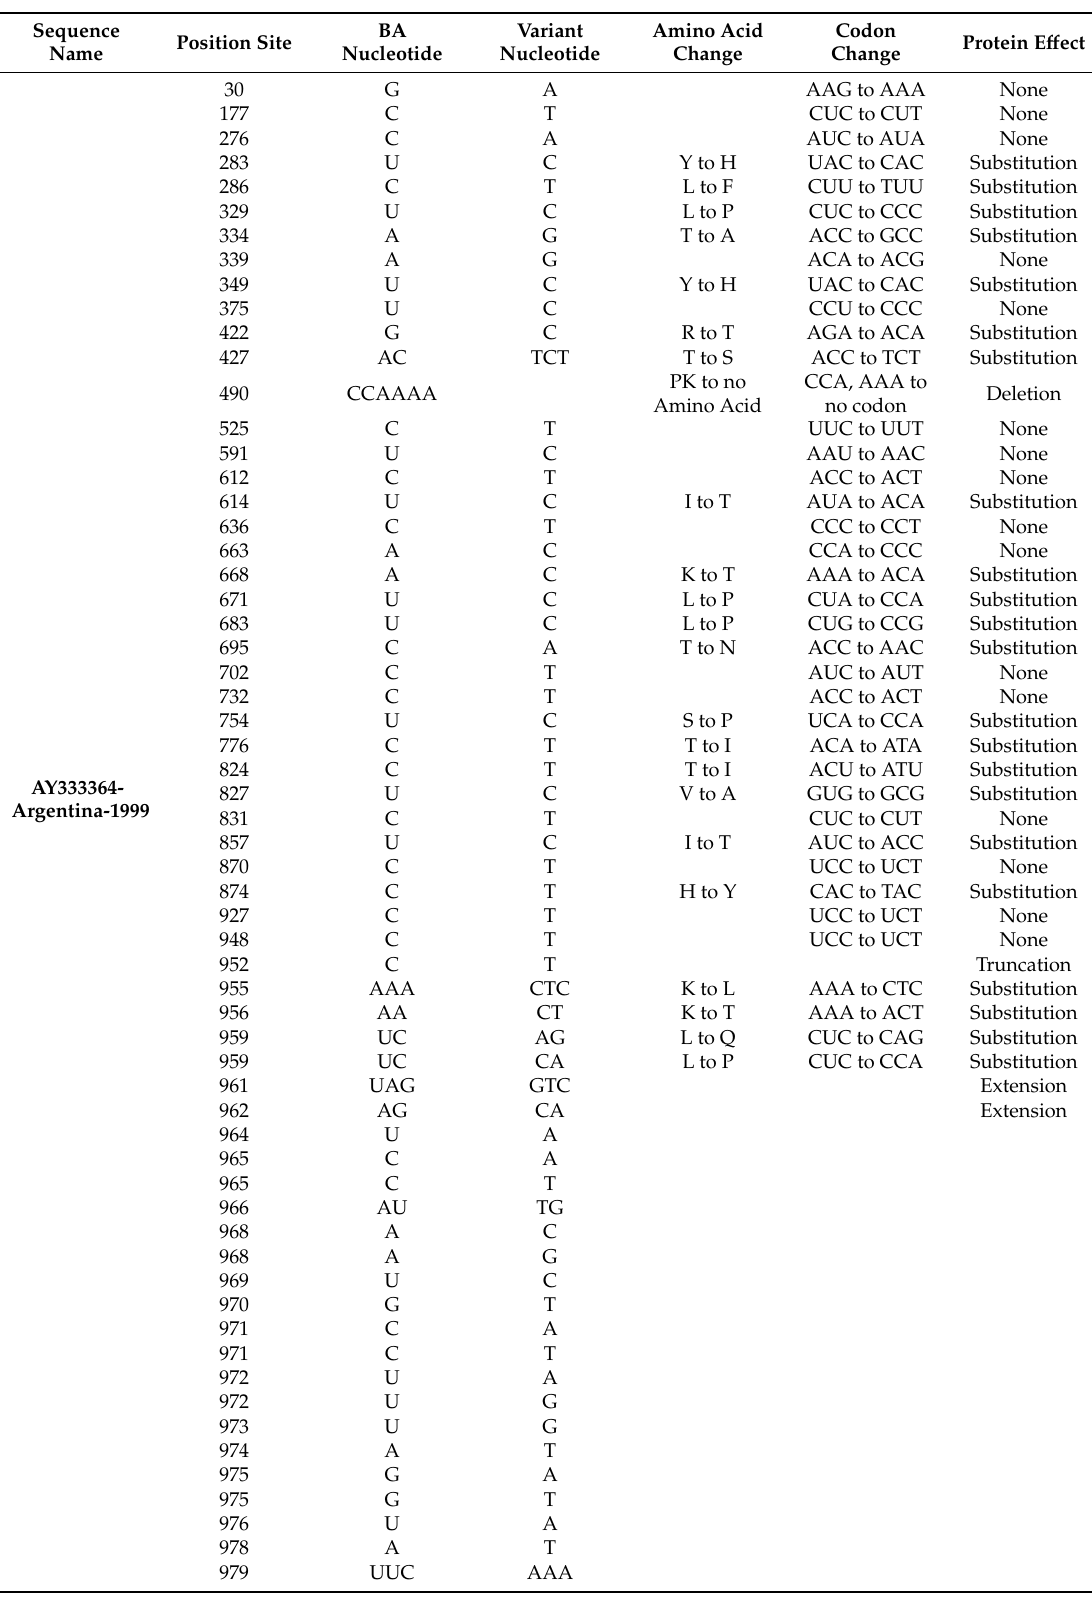
Table 3. The nucleotide variation between the RSV-B Jeddah strains and the BA